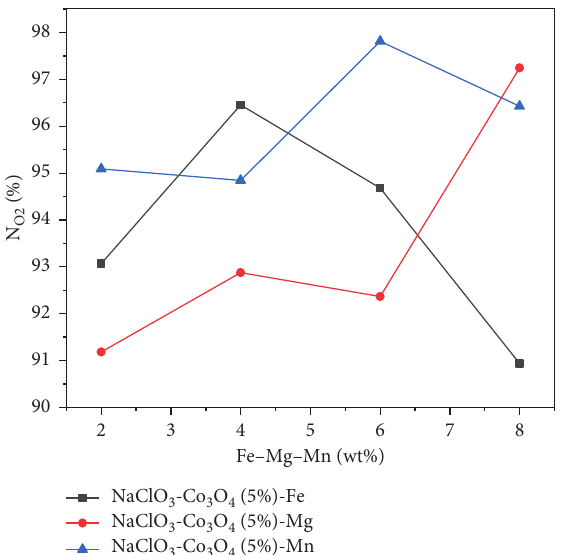
Figure 7: NaClO 3 –5% Co 3 O 4 metal effective oxygen production efficiency curve.